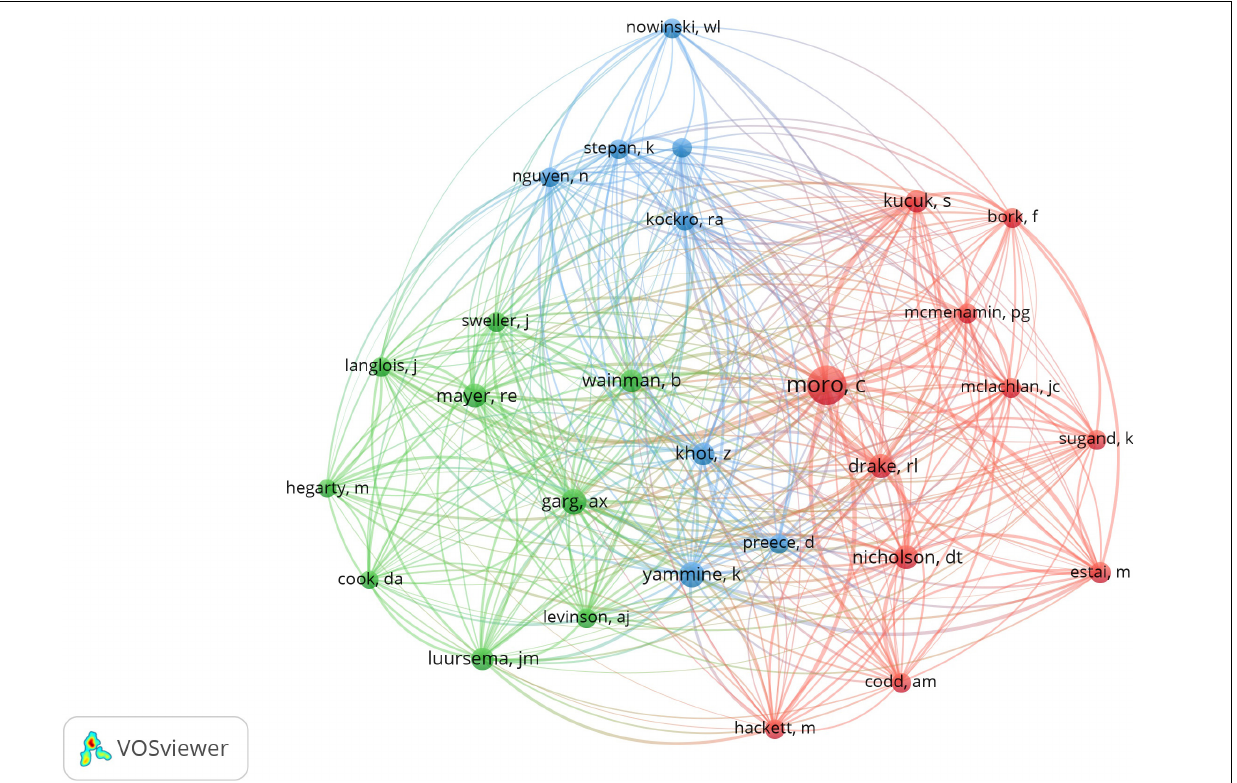
FIGURE 3 | A visualization of author co-citation